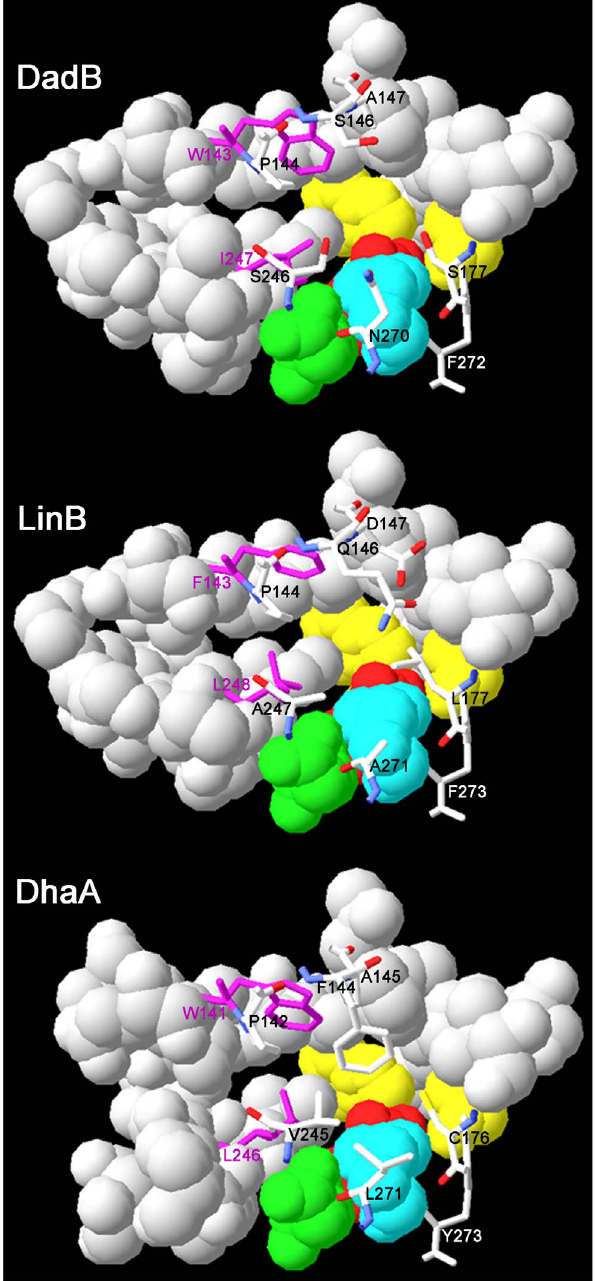
Figure 3. Active sites and access tunnels of LinB, DadB and DhaA. Yellow, cyan, green and red indicate the halide-binding residues, the basic residues, the acidic residues, and the nucleophile residues, respectively. Magenta indicates the two residues at the adjacent position of the main tunnel and the slot tunnel. The pictures were produced with Swiss-PdbViewer